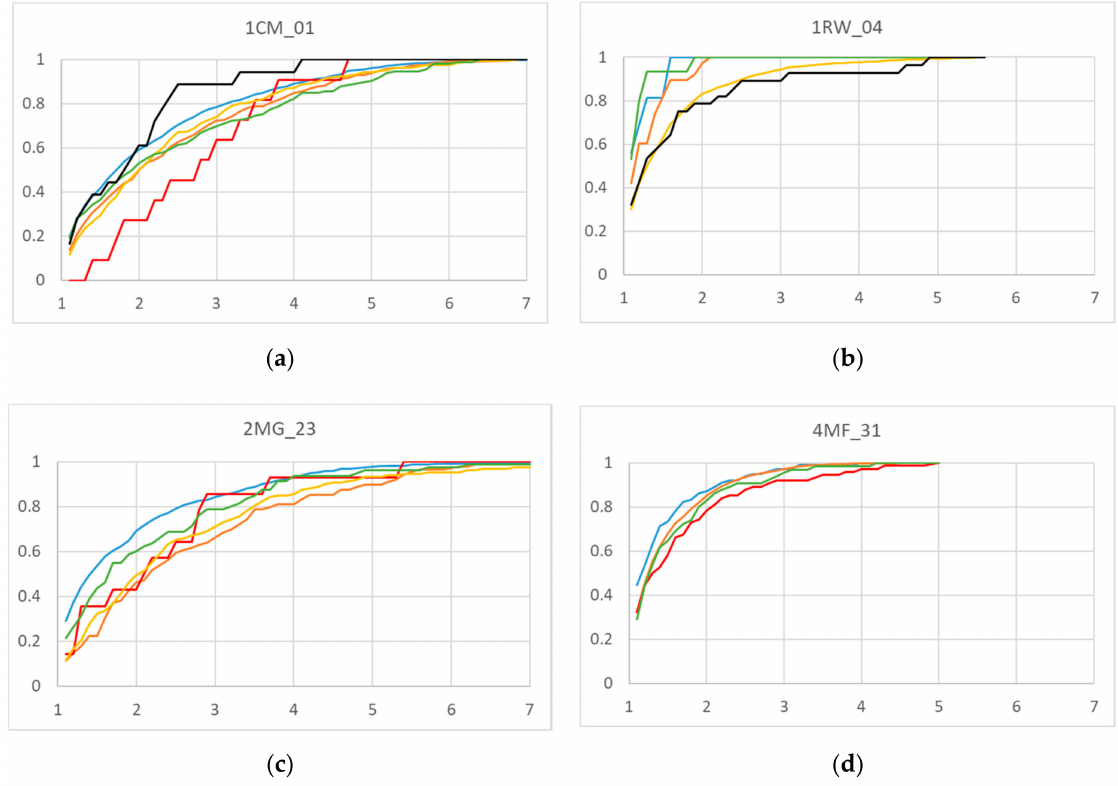
Figure 7. Particle size distributions of various mineralogical classes in samples. ( a ) Mine 1 continuous miner, ( b ) Mine 1 roadway, ( c ) Mine 2 longwall maingate, ( d ) Mine 4 longwall midface. X-axis = particle size (microns) and y-axis = cumulative